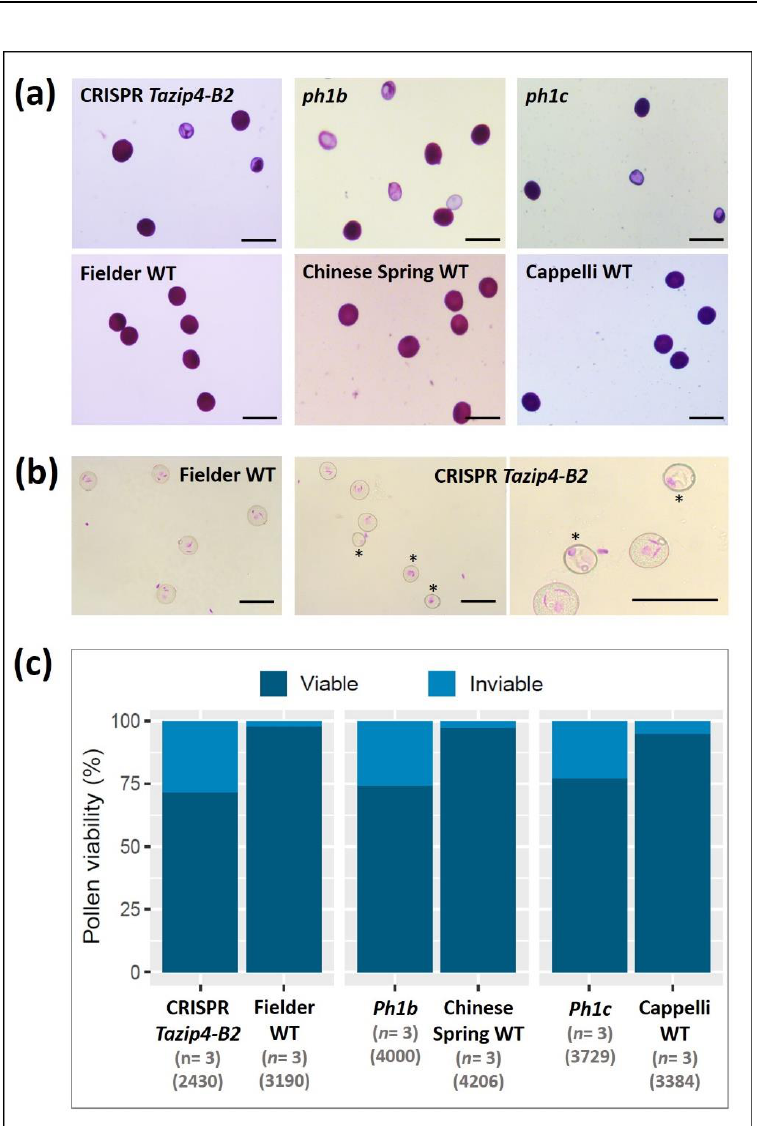
Figure 7. Pollen viability of the Tazip4-B2 mutants. ( a ) Pollen with magenta colour after staining with Alexander stain was considered viable, whereas blue-green pollen was considered